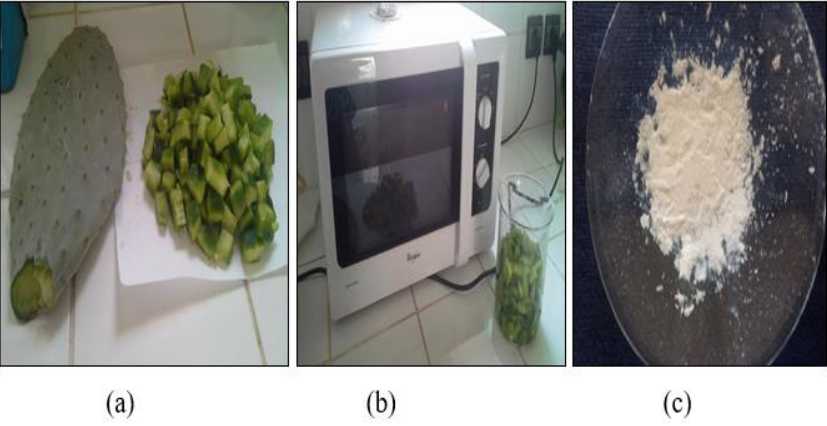
Figure 1. Pectin extraction from prickly pear cladodes ( a ); Microwave device ( b ); Pectin powder ( c